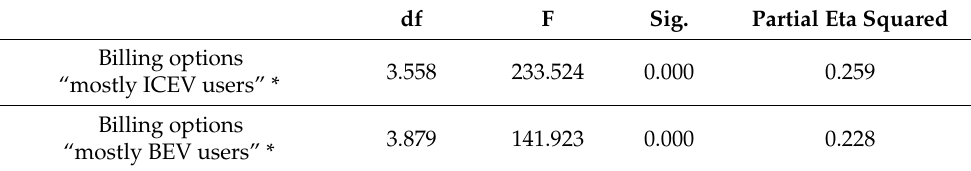
Table 3. Greenhouse–Geisser corrected tests of billing options’ within subject